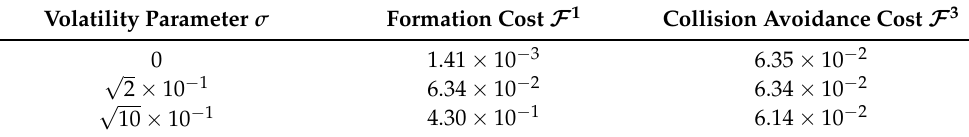
Table 1. Comparison with interaction